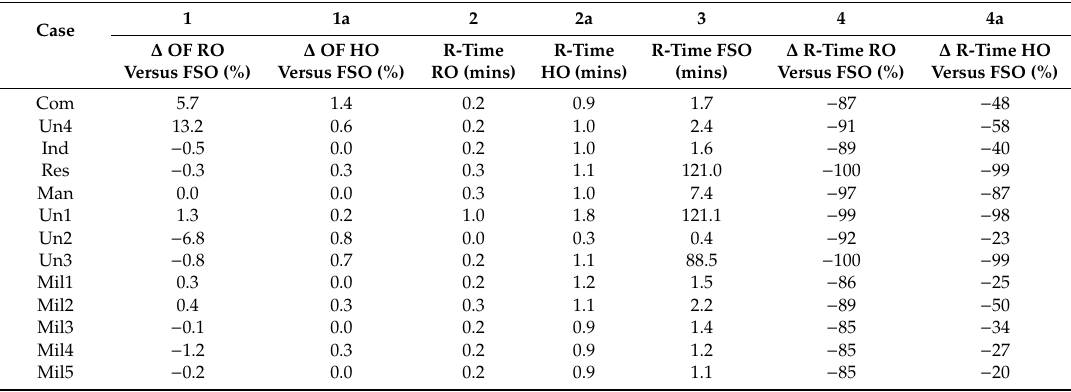
Table 5. Objective function as well as run-time di ff erences between the HO and FSO. OF: Objective Function; R-time: Run-time; RO: Representative Optimization; HO: Hybrid Optimization; FSO: Full-Scale Time-Series